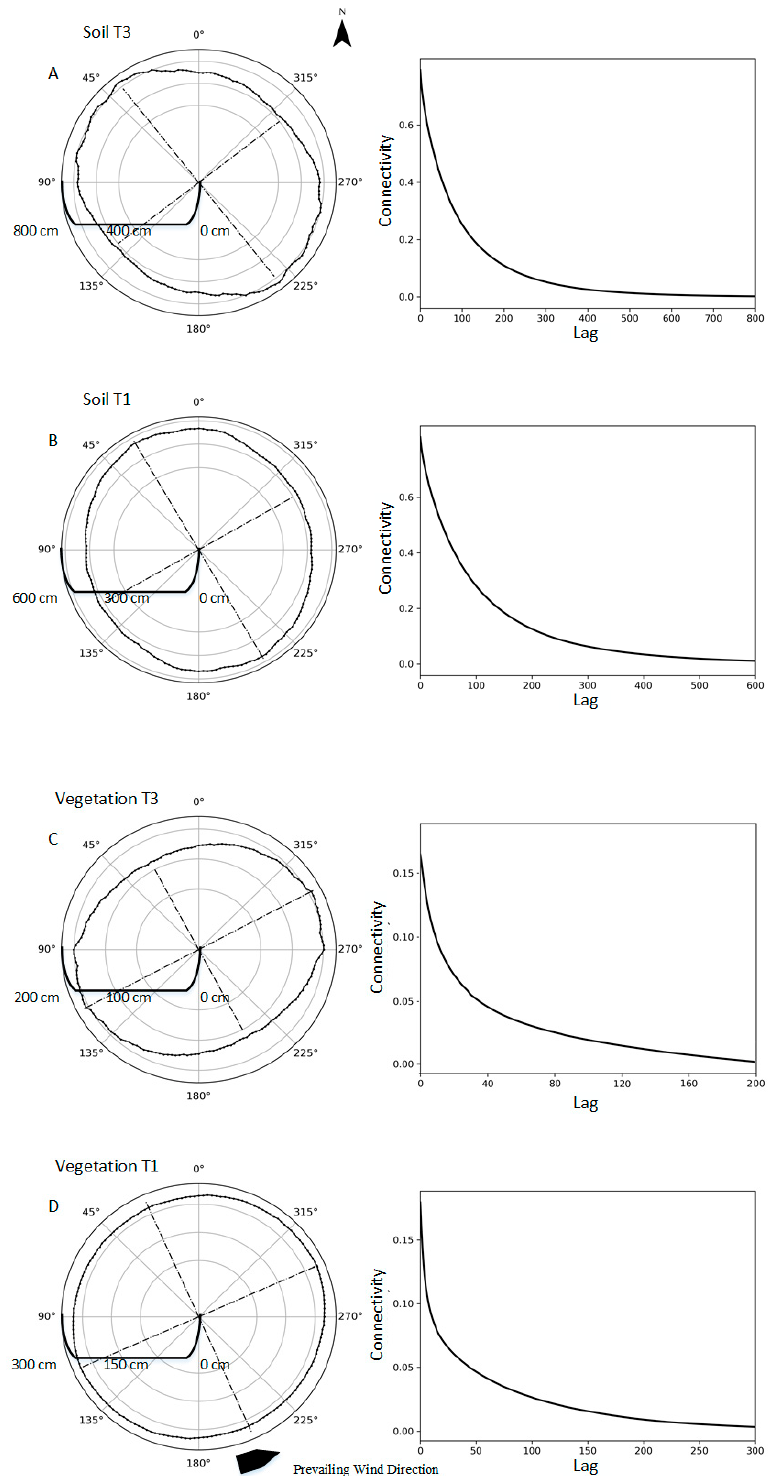
Figure 8. Polar plots of the average size of inter-plant gaps and vegetation patches using the method of McGlynn and Okin [9] for the upwind portion of Treatment 3 (75% grass removal) and Treatment 1 (25% grass removal) (left column). The decay curves of connectivity of interplant gaps and vegetation patches for the upwind portion of Treatment 3 and Treatment Control 1 (right column). The directional property of Treatment 3 ( A , C ); the directional property of Treatment 1 ( B , D ). This figure was revised from Zhang et al.